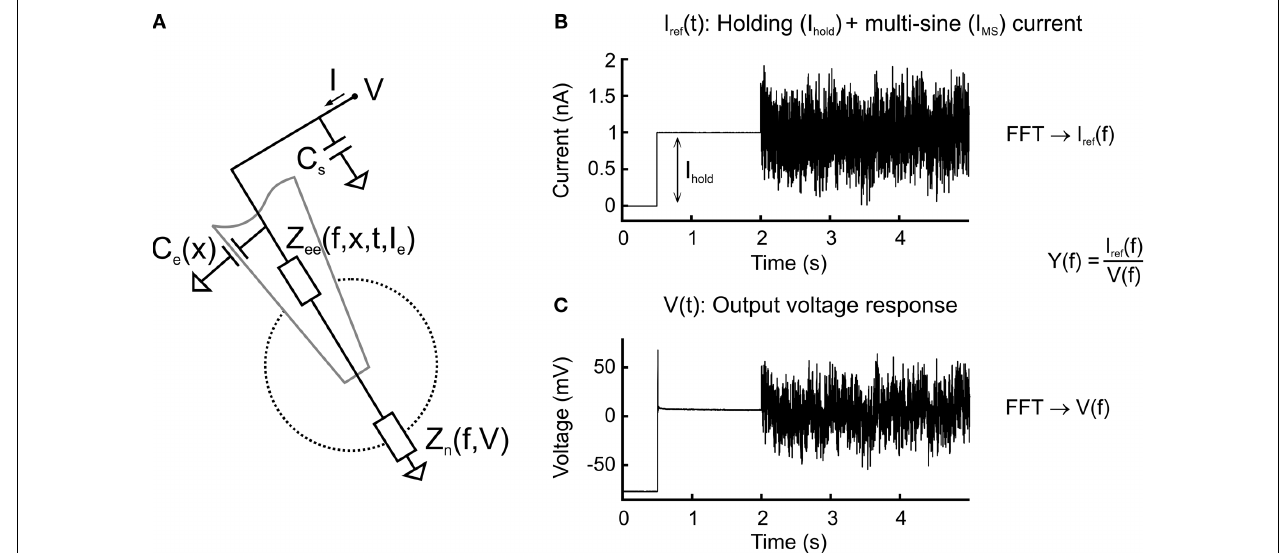
FIGURE 1 | Circuit diagram and multi-sine measurement procedure. (A) Equivalent circuit diagram of a sharp electrode inside a neuron. The neuron is described as a frequency- and voltage-dependent impedance, Z electrode is described as a frequency-, depth-, time- and current-dependent impedance Z ( f , x , t , I ) serial to and a depth-dependent capacitance C ee e parallel to the neuron; additional constant parallel stray capacitance C